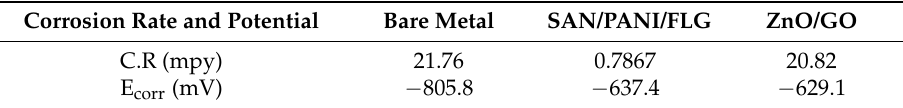
Table 8. Corrosion rate data from Tafel scan in produced